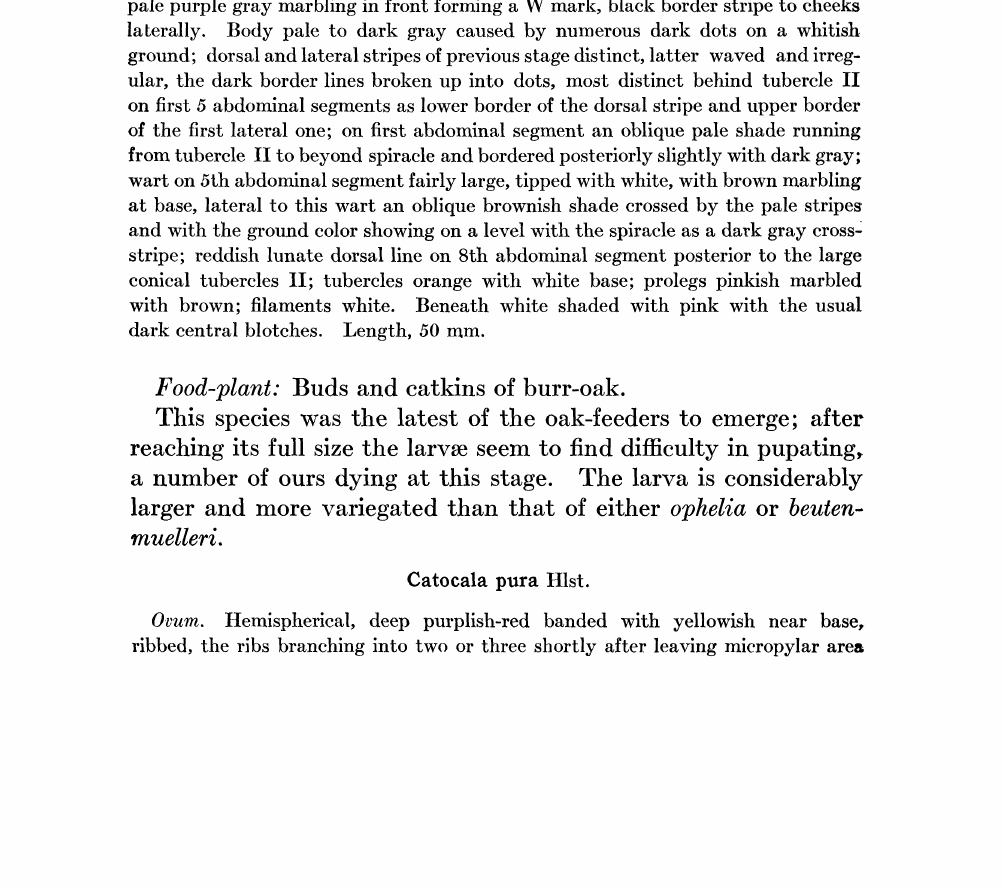
Psyche [December portion of cheeks and dark curved lateral border to same; clypeus with central dark line. Body pale gray; dorsal and three lateral creamy stripes prominent, bordered by brown lines; 5th abdominal segment with small dorsal wart tipped with reddish at apex; from this wart a dusky lateral shade extends downward to the prolegs, crossed by the pale tateral stripes; tubercles reddish, tubercle II of 8th abdominal segment conical, with dark lunate reddish line posterior to it; prolegs striped with black. Length, 18 mm. Stage IV. Head gray, apex of lobes tinged with orange-red; lobes strongly marbled vertically forming W mark frontally; geminate lateral black curved line and central line to clypeus. Body gray with paler creamy stripes; dorsal stripe, as usual, tending to diamond-shaped enlargements, with centro-dorsal dark line and similar colored border-line, most prominent at rear of 1st four abdominal segments; three pale lateral stripes bordered with blackish lines which tend to break up into dots; on 1st abdominal segment a dark oblique lateral shade extends forward from tubercle II toward the 8rd pair of legs; dorsal wart on 5th abdominal segment flesh-colored with diffuse darkish shade extending from it laterally to prol.egs; tubercles,orange; curved line behind the conical dorsal tubercles on 8th abdominal segment brownish. Beneath whitish with the usual dark blotches. Length, 0-80 ram. Stage V. Head whitish tinged with orange in front and along sides of cheeks; pale purple gray marbling in front forming a W mark, black border stripe to cheeks laterally. Body pale to dark gray caused by numerous dark dots on a whitish ground; dorsal and lateral stripes of previous stage distinct, latter waved and irreg- ular, the dark border lines broken up into dots, most distinct behind tubercle II on first 5 abdominal segments as lower border of the dorsal stripe and upper border of the first lateral one; on first abdominal segment an oblique pale shade running from tubercle II to beyond spiracle and bordered posteriorly slightly with dark gray; wart on 5th abdominal segment fairly large, tipped with white, with brown marbling at base, lateral to this wart an oblique brownish shade crossed by the pale stripes and with the ground color showing on a level with the spiracle as a dark gray cross2 stripe; reddish lunate dorsal line on 8th abdominal segment posterior to the large conical tubercles II; tubercles orange with white base; prolegs pinkish marbled with brown; filaments white. Beneath white shaded with pink with the usual dark central blotches. Length, 50